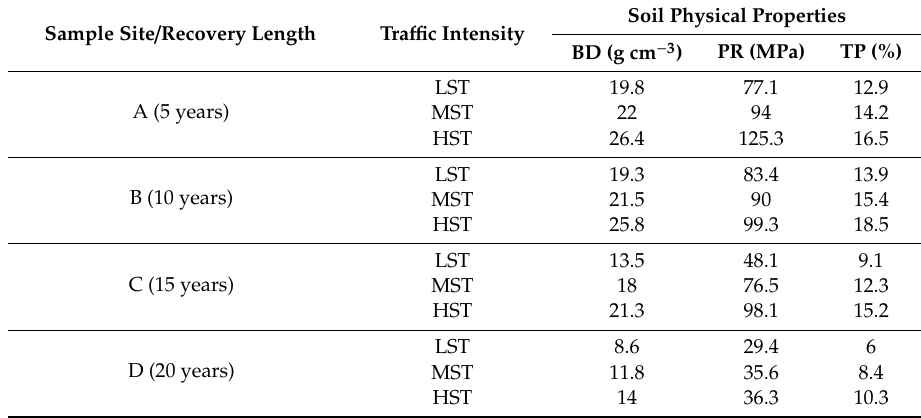
Table 5. Soil properties’ recovery rate (change percent in di ff erent years after the skidding operations) in di ff erent tra ffi c intensities.